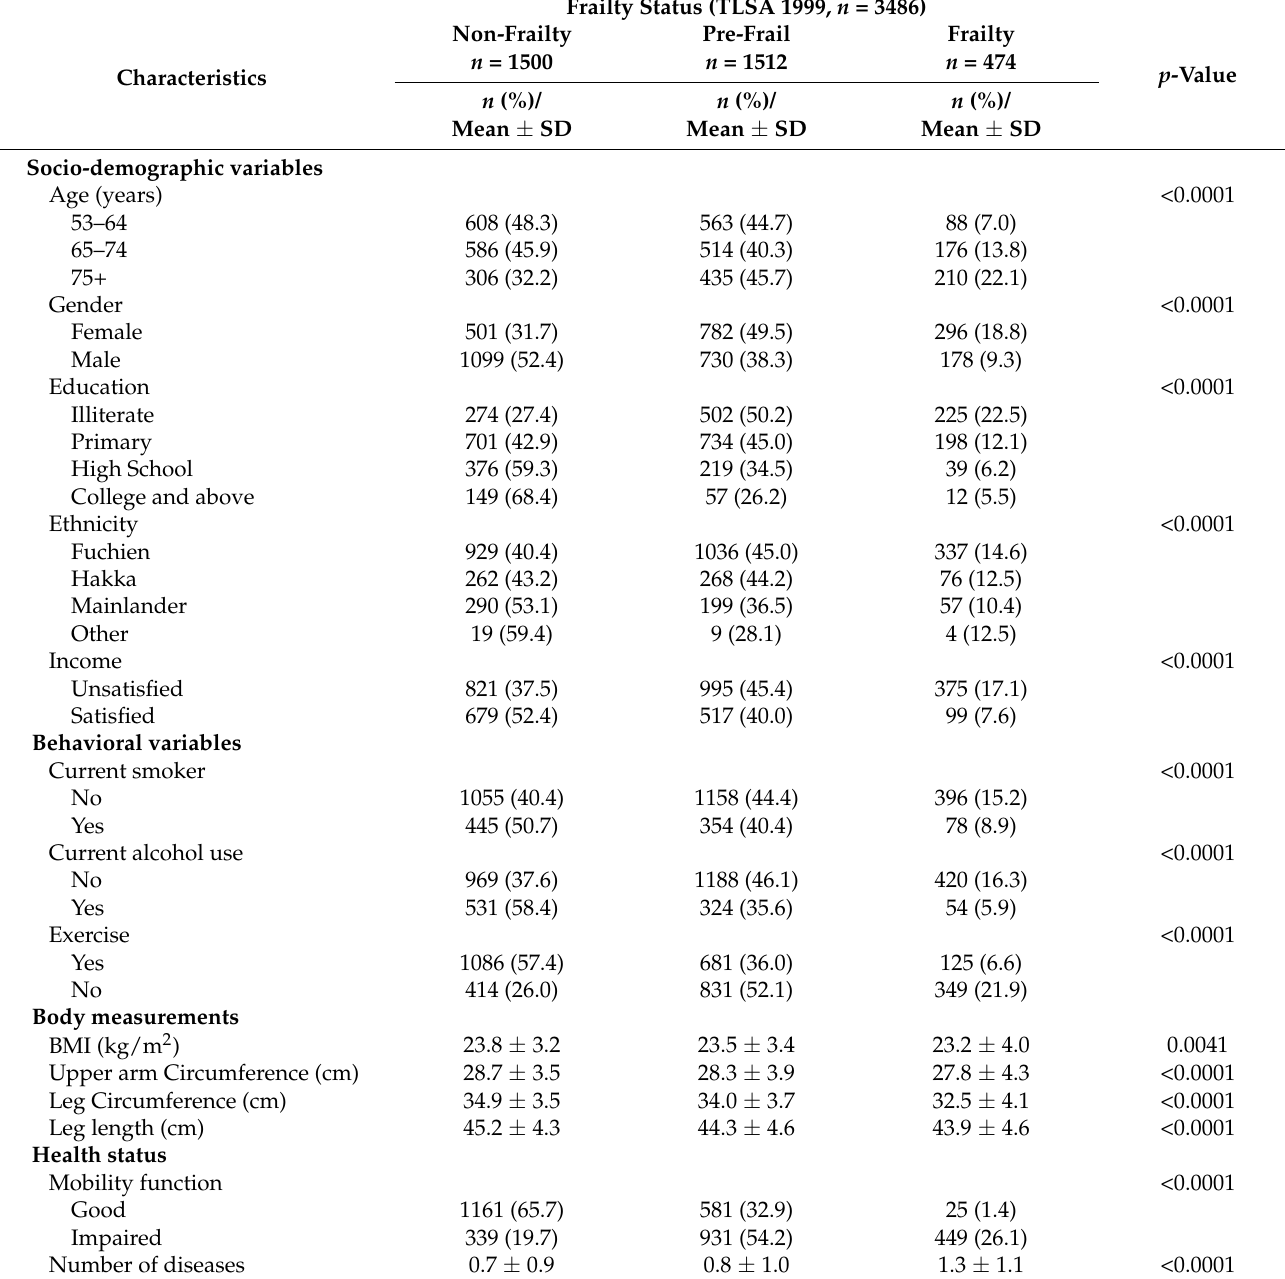
Table 2. Baseline (1999) characteristics stratified according to frailty status in participants. Frailty Status (TLSA 1999, n =